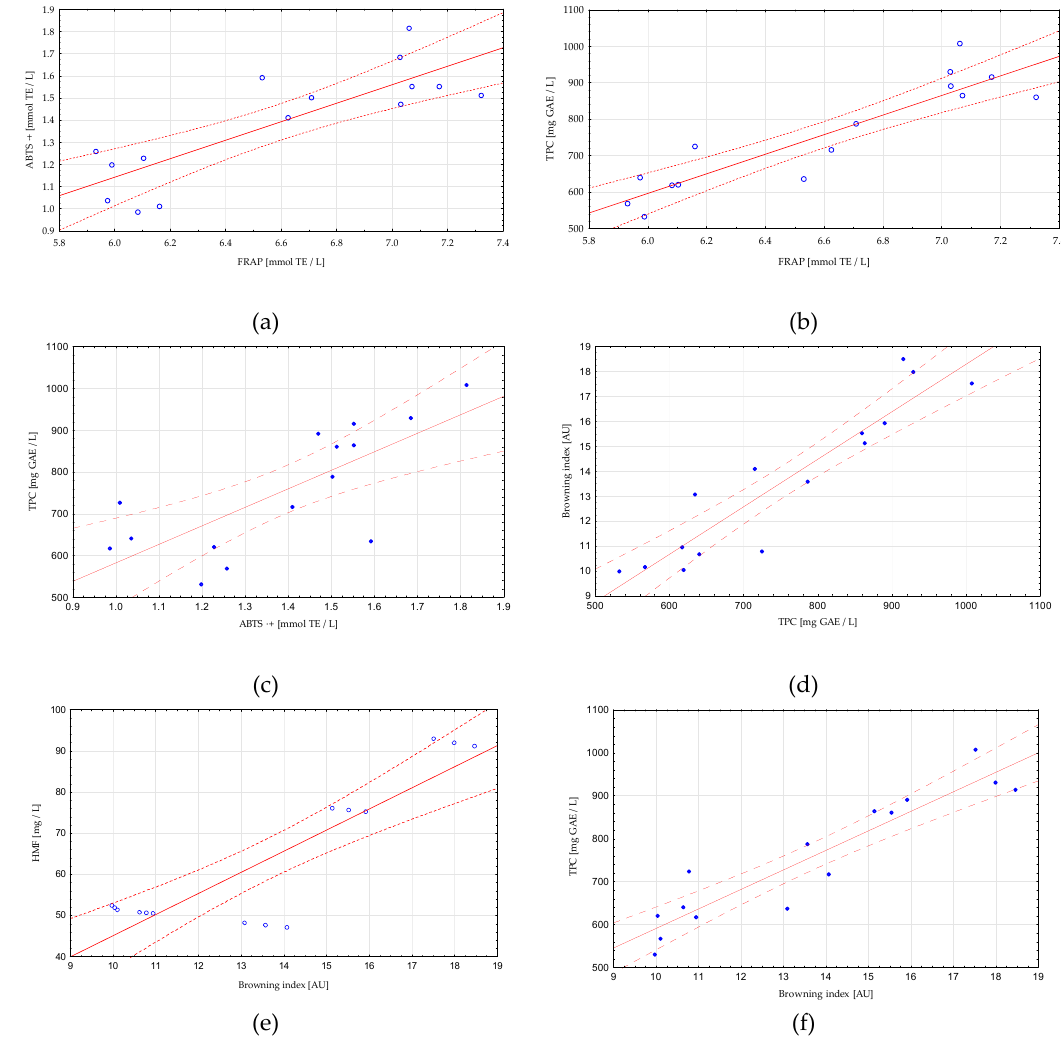
Figure 3. Scatter graphs for selected variables. Relationship between: ( a ) FRAP and ABTS •+ assays, ( b ) FRAP and TPC (content of polyphenols) assays, ( c ) ABTS •+ and TPC assays, ( d ) TPC and browning index, ( e ) HMF and browning index, ( f ) browning index and TPC.